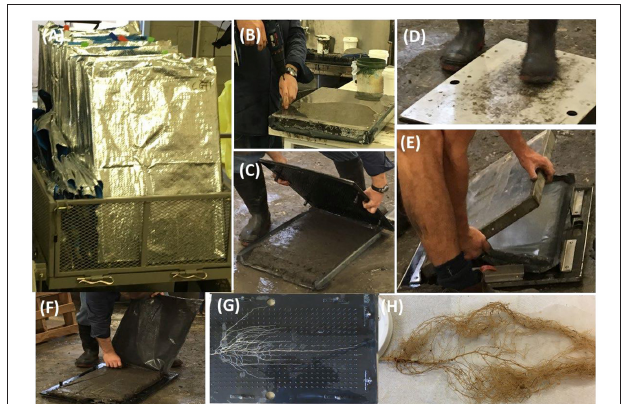
FIGURE 2 | Recovering intact root system architecture. (A) Root chambers brought in the soil laboratory, (B) screws are removed from the perplex panels, (C) top panel is removed so that pin board can be inserted, (D) pinboard is inserted with pressure, (E) panel of other side is removed, (F) black plastic holding the soil is removed, (G) a washed intact root system on the pinboard, and (H) a washed root system after storing in the ethanol for further